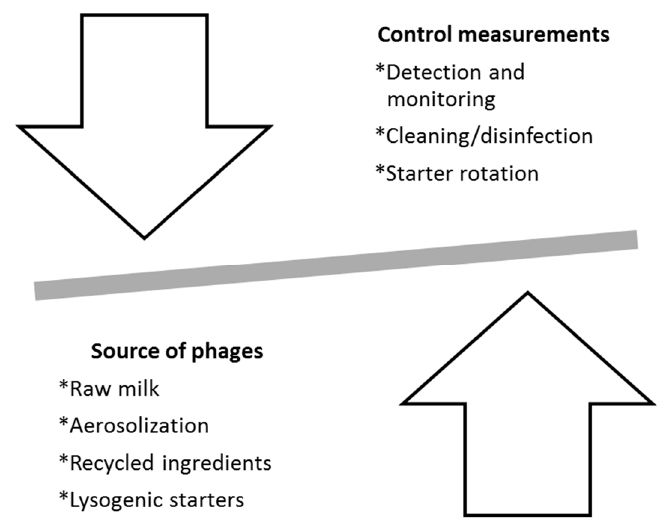
Figure 1. Factors that contribute to the presence of phages in dairy settings.